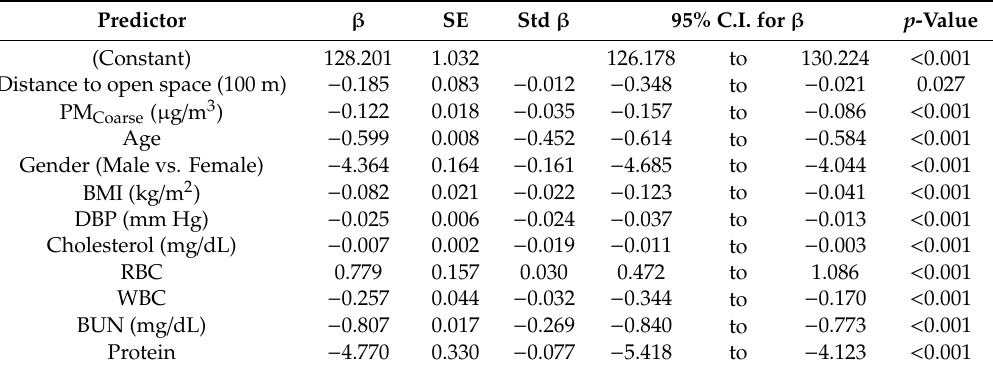
Table 5. Multiple linear regression of predictors on